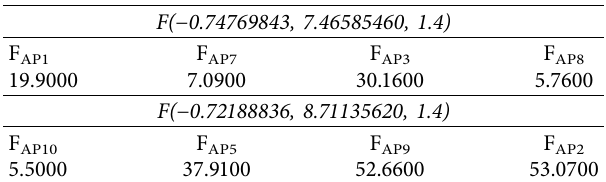
Table 4: Te fngerprints of point ( − 0.74769843, 7.46585460,